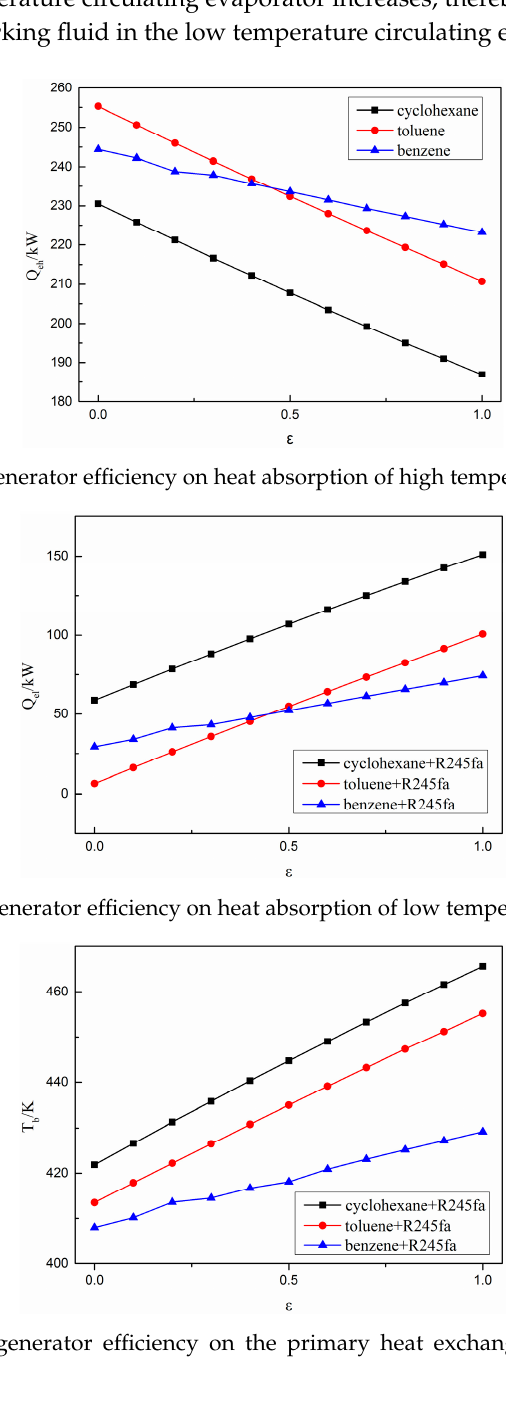
Figure 5. Effect of regenerator efficiency on the primary heat exchange outlet temperature of exhaust gas.